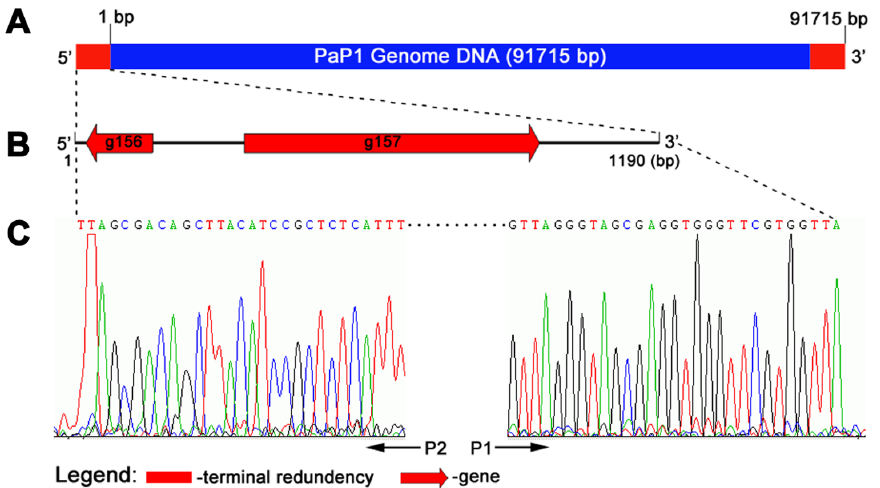
Figure 5. Structure of PaP1 terminal redundancy. (A) PaP1 genome DNA with terminal redundancy at both ends. The sequence data of the PaP1 genome are calculated from 1 bp to 91,715 bp. (B) Putative genes within the PaP1 terminal redundancy. (C) Terminal run-off sequencing chromatograms of both ends of the PaP1 genome. The sequencing direction of primers P1 and P2 is indicated by the black arrows.